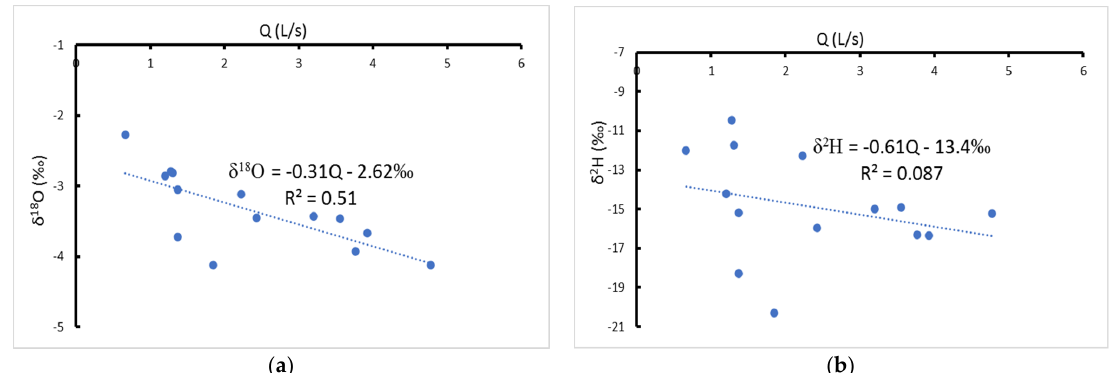
Figure 6. Plots of Albert Farm spring yield versus ( a ) δ 18 O with a correlation of 0.51 and ( b ) δ 2 H with a very poor correlation 0.087.